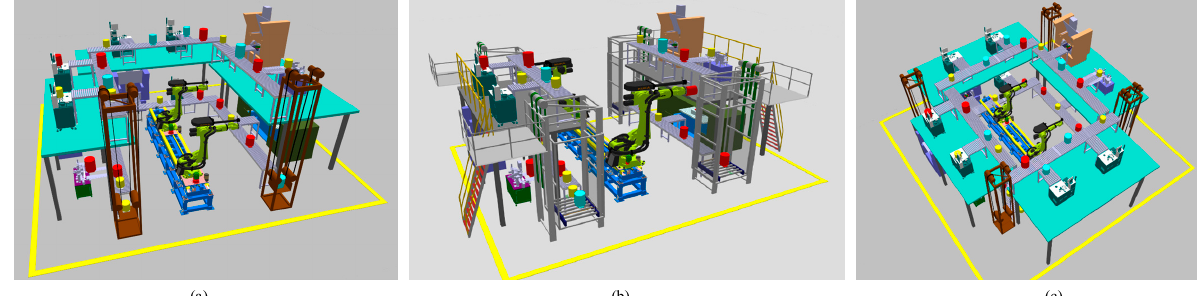
Figure 4. Equipment layout within a single manufacturing cell. ( a )—U-shaped manufacturing cell; ( b )—linear manufacturing cell; ( c )—circular manufacturing cell.